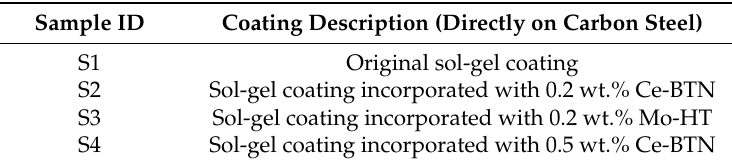
Table 3. Description of coatings for EIS study.